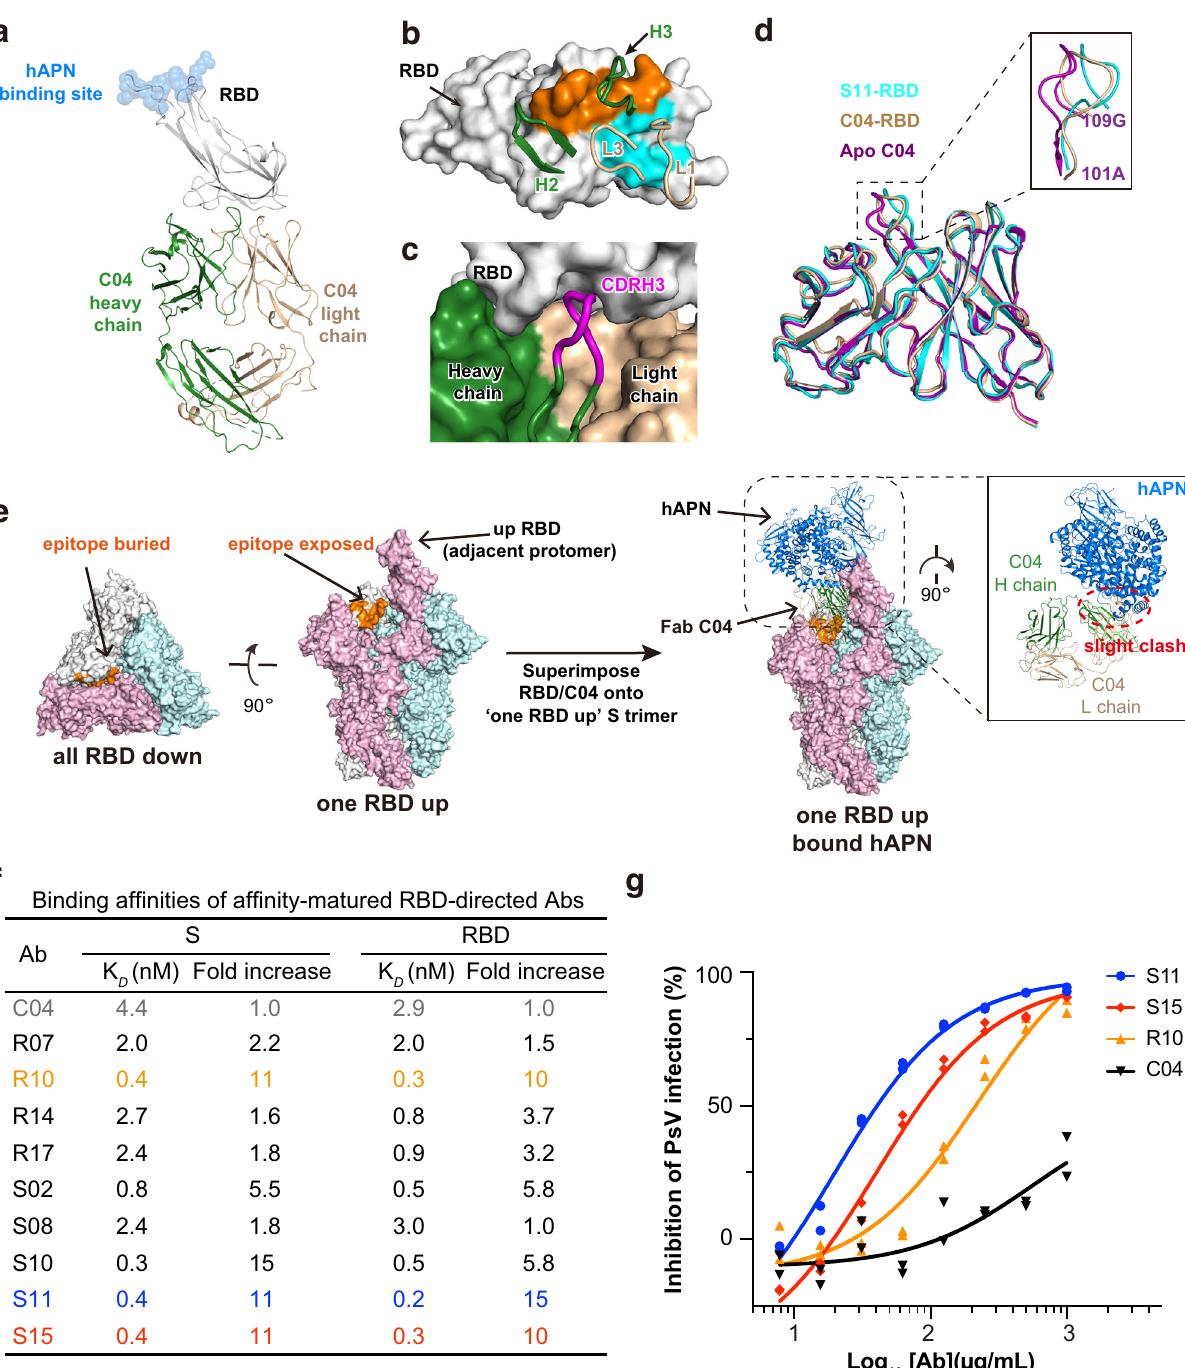
Fig. 4 C04 binds to the distal end of 229E RBD and neutralizes 229E PsV after af fi nity maturation. a Crystal structure of Fab C04 in complex with 229E RBD in cartoon representations. The heavy and light chain of C04 are colored dark green and wheat respectively, while 229E RBD are colored gray. The binding site of host receptor hAPN is depicted with blue spheres. b Contact residues are colored orange (heavy chain) and blue (light chain) on surface representation of 229E RBD. CDR loops engaging 229E RBD are shown and labeled. c The heavy (dark green) and light chain (wheat) of C04 and the RBD (gray) are shown as surface representations. CDRH3 (magenta) is depicted in cartoon to illustrate its neat fi tting into the surface pocket on 229E RBD. d Structural superimposition of free C04 (purple), RBD-bound C04 (wheat) and RBD-bound S11(blue) illustrating the conformational change of CDRH3 upon binding RBD. All structures are shown as cartoon representations and the inset is the close-up view of CDRH3 region. e Left: The epitope of C04 appears buried in all-RBD-down conformation but becomes fully exposed in one-RBD-up conformation. Right: Binding of Fab C04 would slightly interfere with the binding of hAPN to neighboring ‘ up ’ protomer (colored pink, anti-clockwise).StructureofFabC04-bound229EStrimer wasmodeled by superimposing thestructureofRBD-C04onto theone-RBD-up229E Strimer.Next,this structure was aligned with hAPN-229E RBD complex based on the 229E RBD in ‘ up ’ position. f Binding af fi nities of parental C04 and af fi nity-matured antibodies against 229E S trimer or RBDwere characterized by SPR. Of the af fi nity-matured antibodies,antibody S11(blue) and S15(red) exhibited up to 11-fold increasein their af fi nity for 229E S trimer and RBD. g Neutralization pro fi les for IgG S11 (blue), S15 (red) and R10 (orange) are compared to that of parental IgG C04 (black) against 229E PsV. Individual data points are shown as fi lled blue circles (S11), red diamonds (S15), orange triangles (R10) and black triangles (C04)